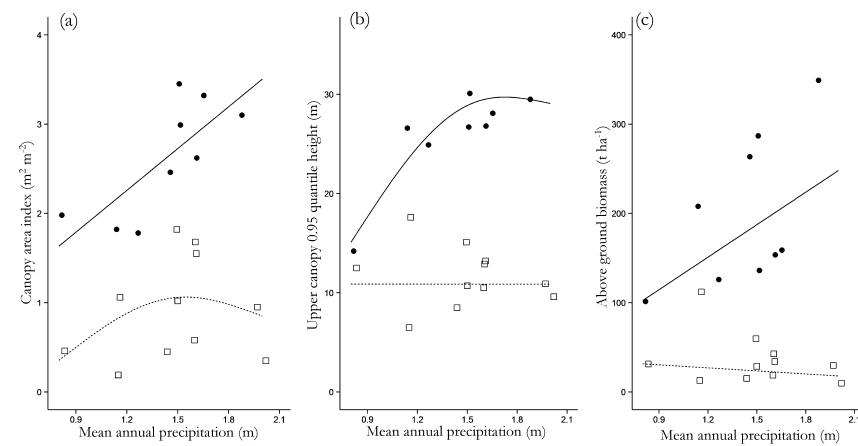
Figure 4. Variations in canopy structural properties in relation to precipitation and vegetation formation type (a) canopy area index, (b) upper 0.95 quantile height and (c) above-ground biomass. ( • ) Forest plots; ( (cid:3) ) savanna plots. Fitted curves (solid for forest plots, dashed for savanna) represent generalised additive model fits.